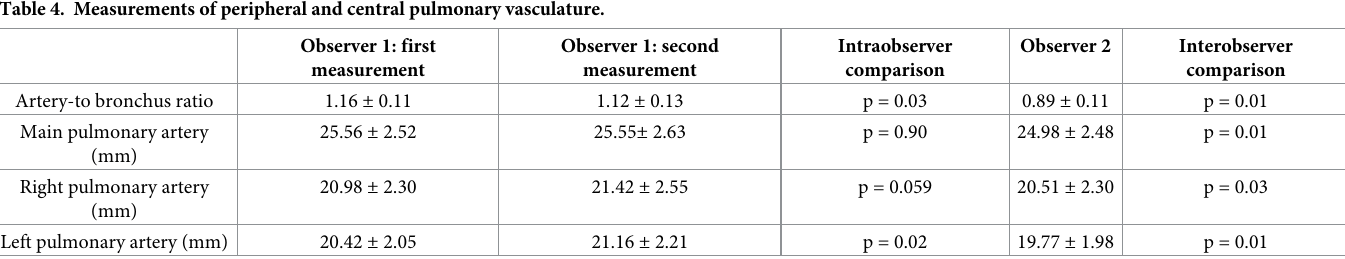
Table 4. Measurements of peripheral and central pulmonary